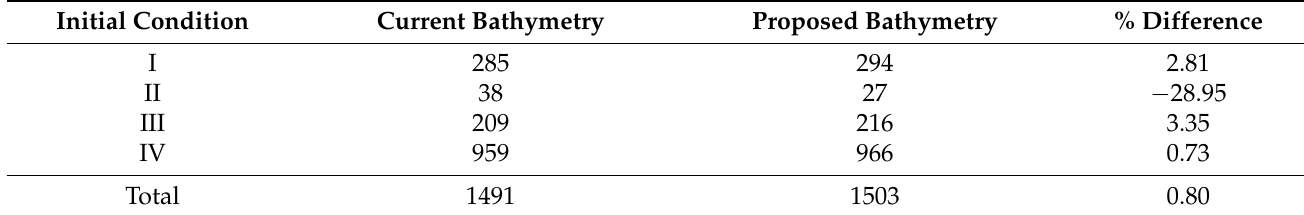
Table 2. Successful larvae count for 2019 conditions.